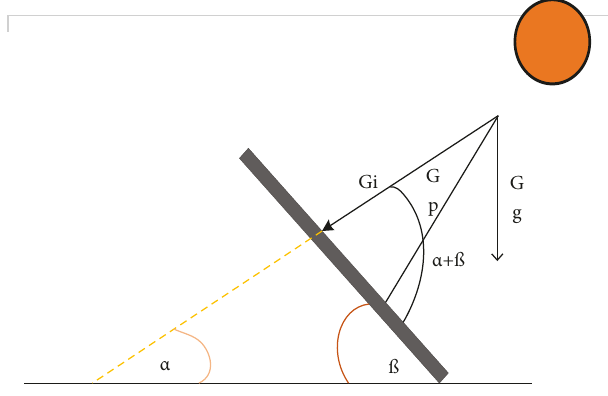
Figure 4: Solar radiation